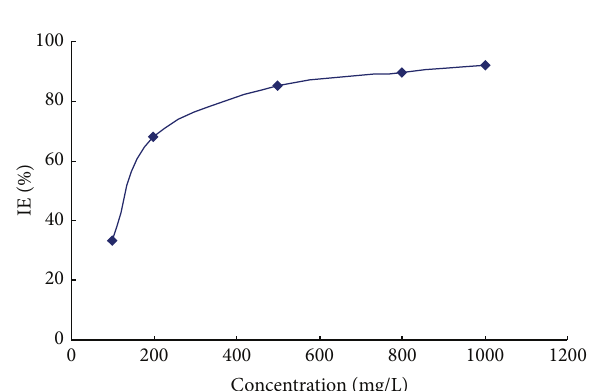
Figure 1: IE of PN4 for Q235A steel dissolution in 3% HCl at different